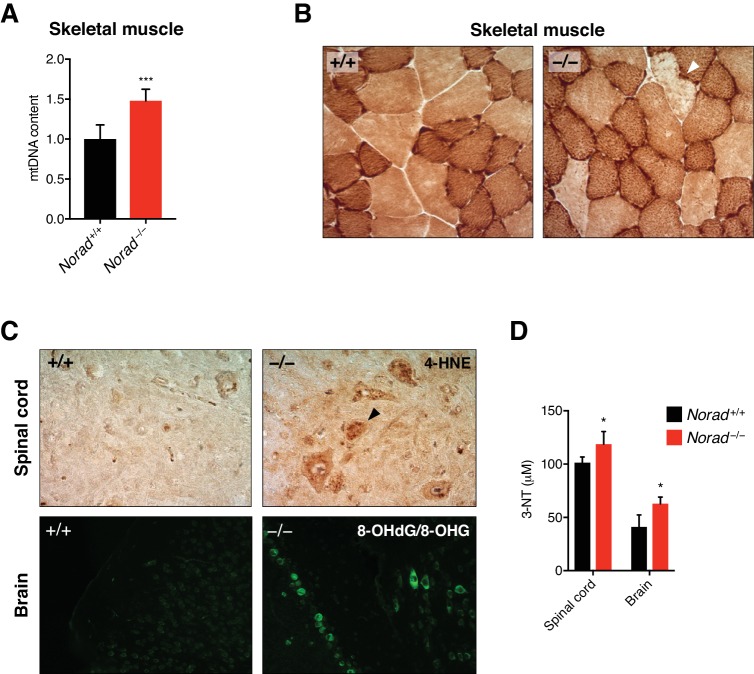
Loss of Norad results in mitochondrial dysfunction.(A) Increased mtDNA content in gastrocnemius muscle of 12-month-old Norad–/– mice. mtDNA was quantified by qPCR and normalized to nuclear DNA (n = 6 mice per genotype). (B) COX histochemistry demonstrating the presence of rare muscle fibers with greatly reduced COX activity in gastrocnemius muscle of 12-month-old Norad–/– mice (arrowhead). (C) Oxidative damage in the CNS of 12-month-old Norad–/– mice. Lipid peroxidation and DNA/RNA oxidation were analyzed in sections of brain stem and cerebellum using 4-HNE immunohistochemistry or 8-OHdG/8-OHG immunofluorescence, respectively. (D) Increased protein oxidation in the CNS of 12-month-old Norad–/– mice, as determined by 3-nitrotyrosine (3-NT) ELISA (n = 3 mice per genotype for brain, n = 4 mice per genotype for spinal cord). Data are represented as mean ± SD in (A) and (D) and p values were calculated using Student’s t test. *p ≤ 0.05, ***p ≤ 0.001.